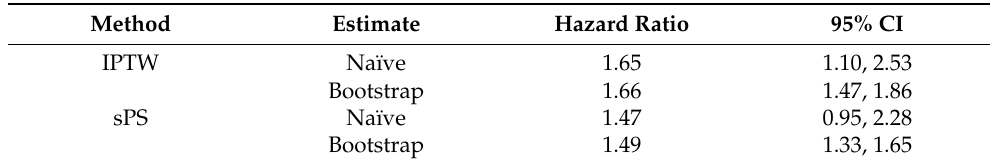
Table 4. Hazard ratios for cancer-related deaths in patients with moderate/severe vs. none/mild on the ESAS depression item at diagnosis.